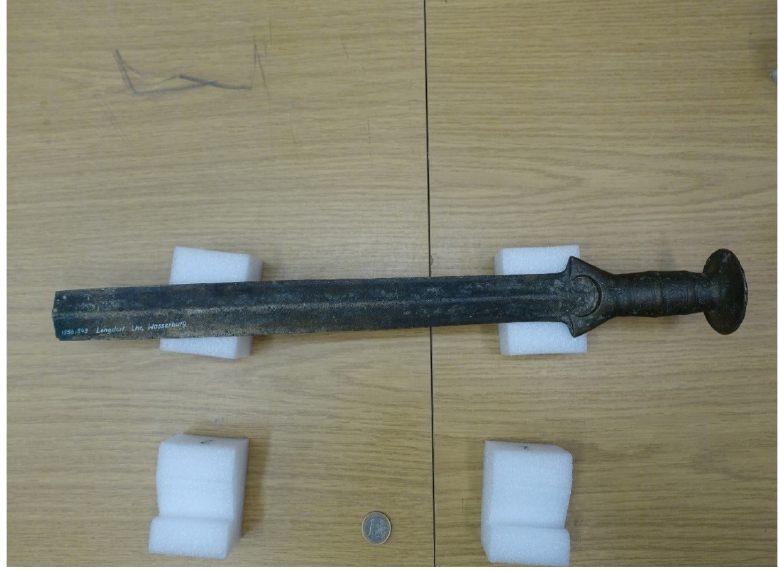
Figure 1. Blade propped up on notched foam blocks for 3D